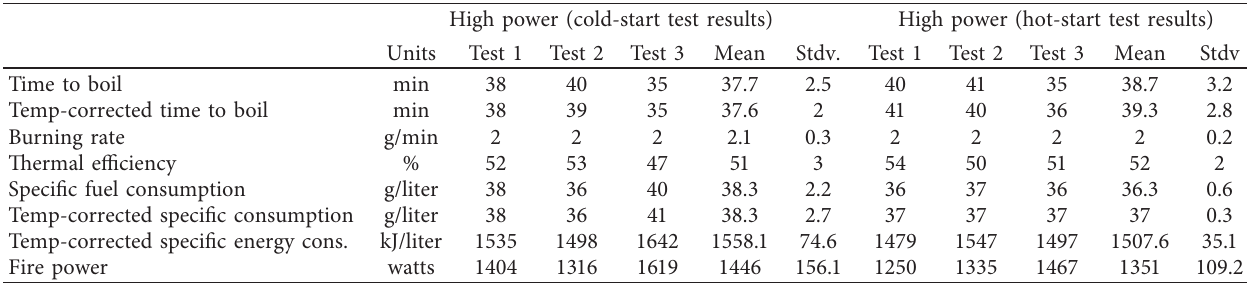
Table 8: Performance of the Jatrok stove using J40 fuel.